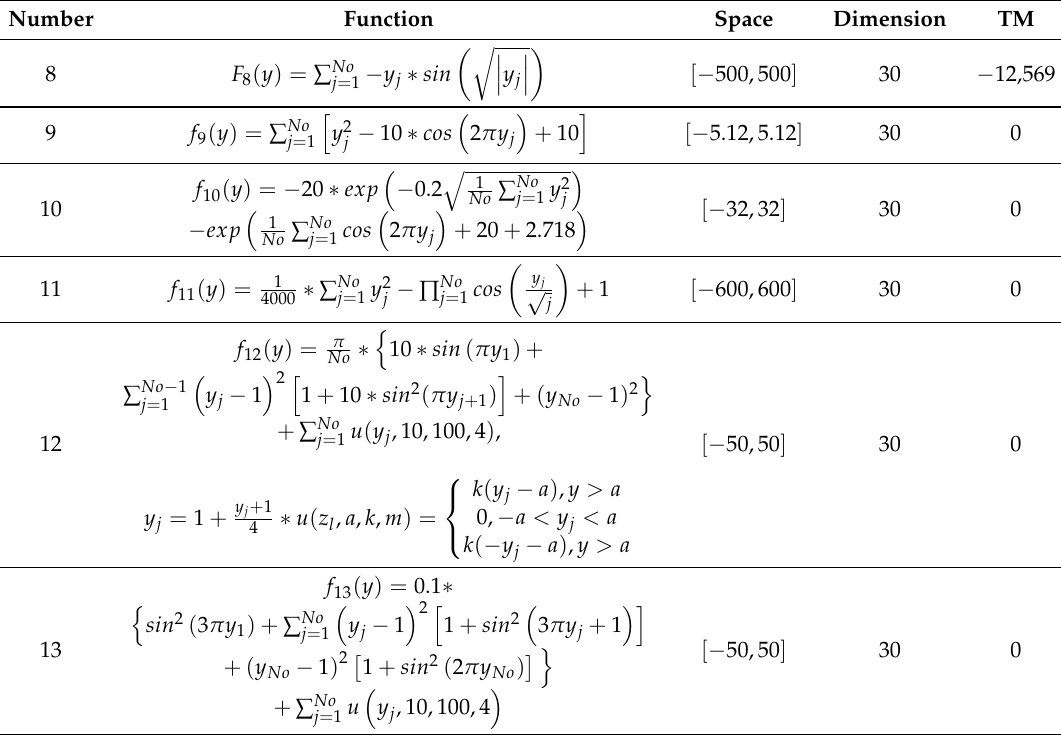
Table 2. Multimodality peak in test